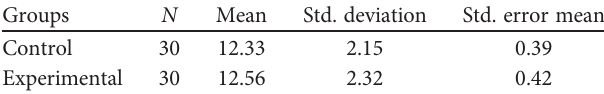
T ABLE 6: Groups ’ mean scores on the accuracy